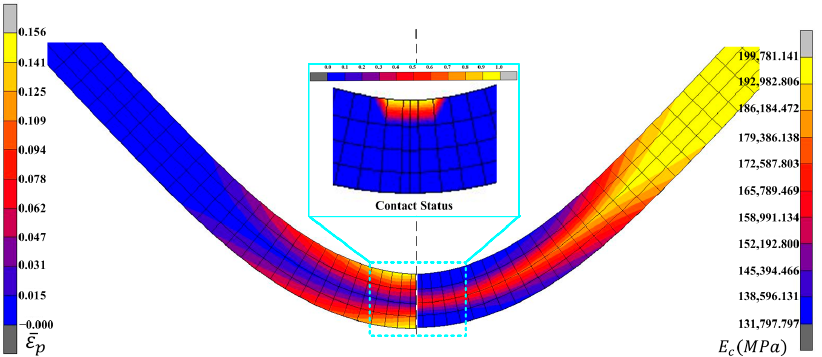
Figure 7. Simulation results of the equivalent plastic strain and chord modulus in three ing.